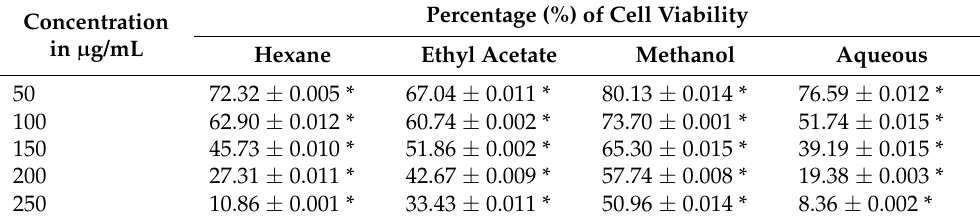
Table 4. Anticancer activity of F. arabica extracts against breast cancer MCF-7 cell line. Concentration in µ g/mL